Question: What kind of plot is shown here?
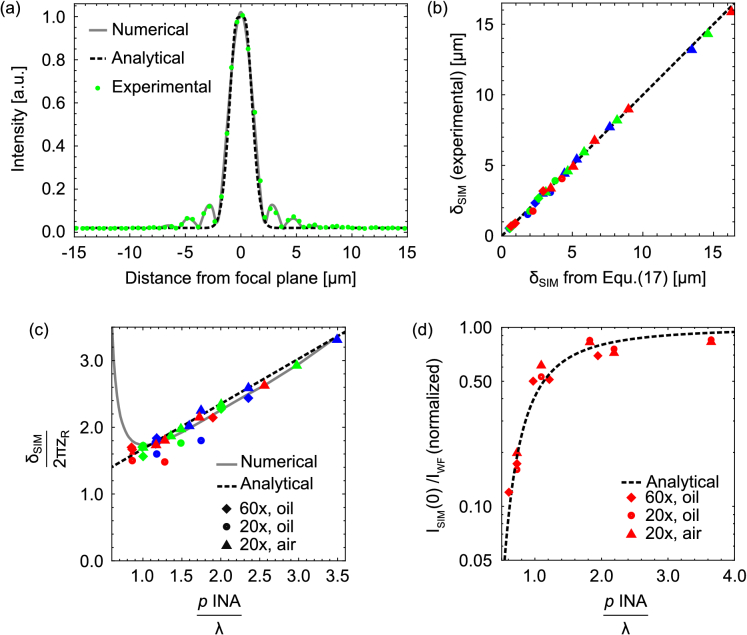
Answer: line